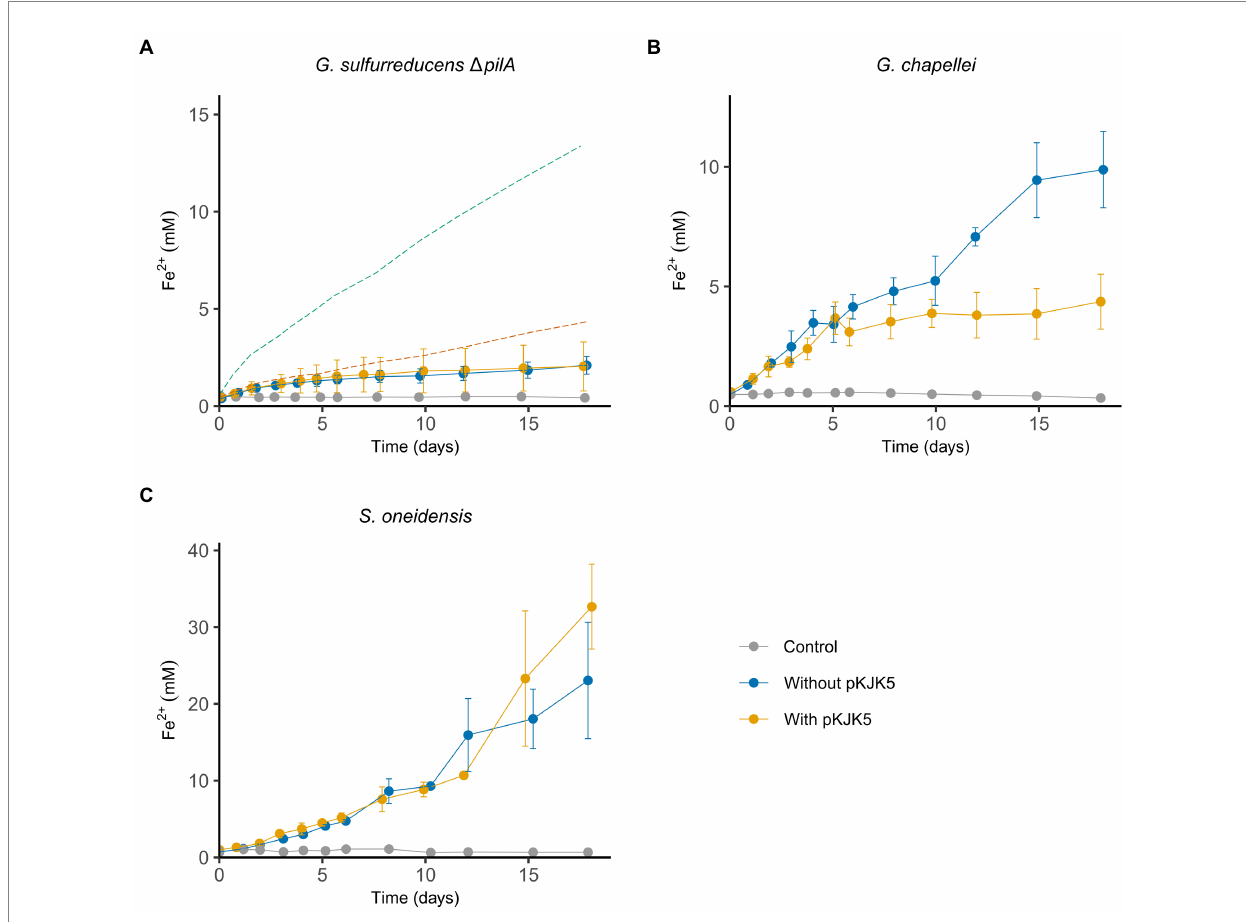
FIGURE 2 pKJK5 specifically inhibits pilA -dependent iron oxide reduction. Reduction of Fe 2 O 3 by G. sulfurreducens Δ pilA [ (A) , n = 6], G. chapellei [ (B) , n = 3] and S. oneidensis [ (C) , n = 3]. Stippled lines (A) show Fe 2 O 3 reduction of G. sulfurreducens WT (green) and G. sulfurreducens WT + pKJK5 (orange) from Figure 1A to ease comparison. All the controls are uninoculated medium. Error bars show